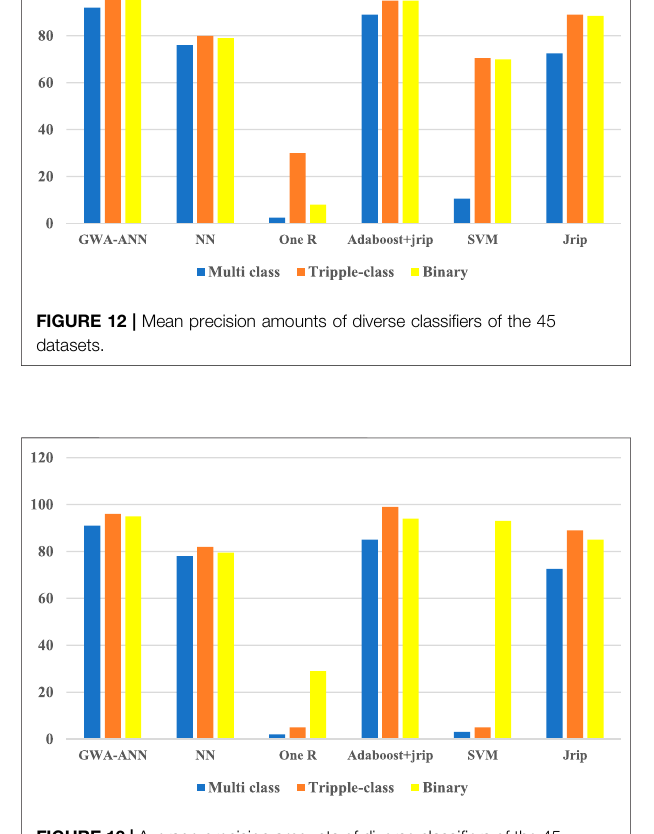
FIGURE 13 | Average precision amounts of diverse classi fi ers of the 45 datasets.